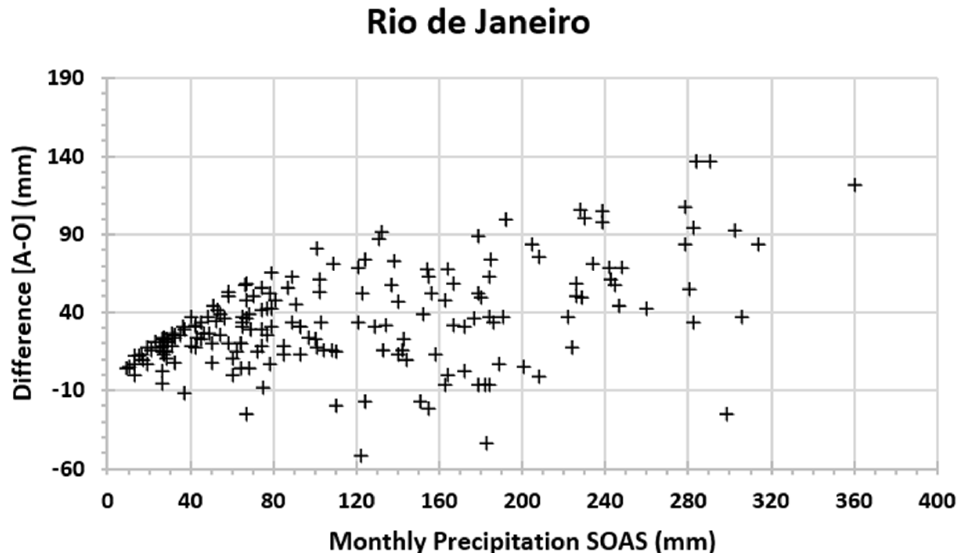
Figure 3. Monthly precipitation average difference (mm) between SOAS (A) and CMPORH (O) as a function of SOAS monthly precipitation average for all months between 2000 and 2015 for Rio de Janeiro State.